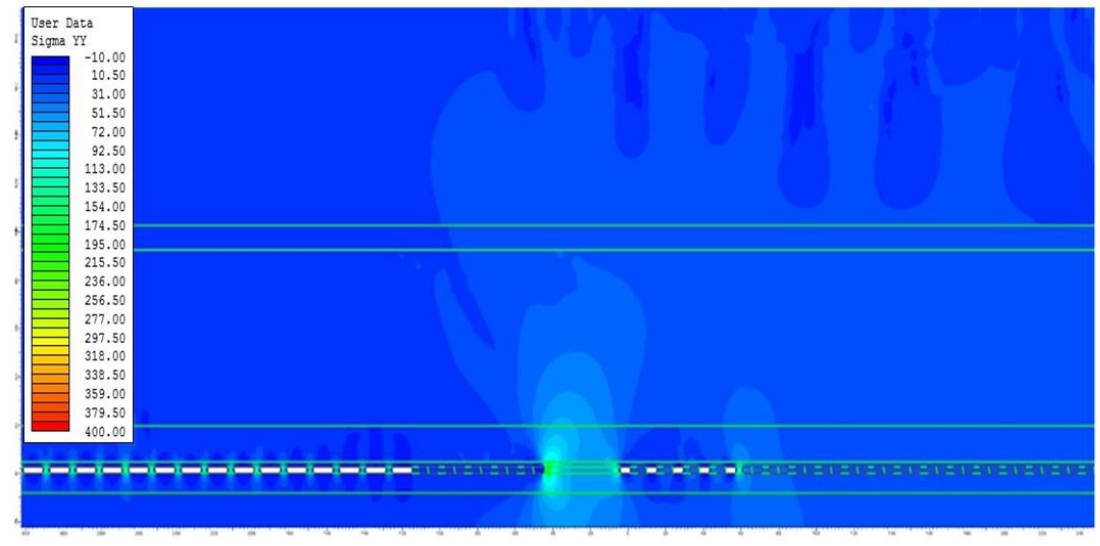
Figure 11. Distribution of vertical stresses σ y for the front distance approximately 60 m from the remnant edge—35th calculation step [11].